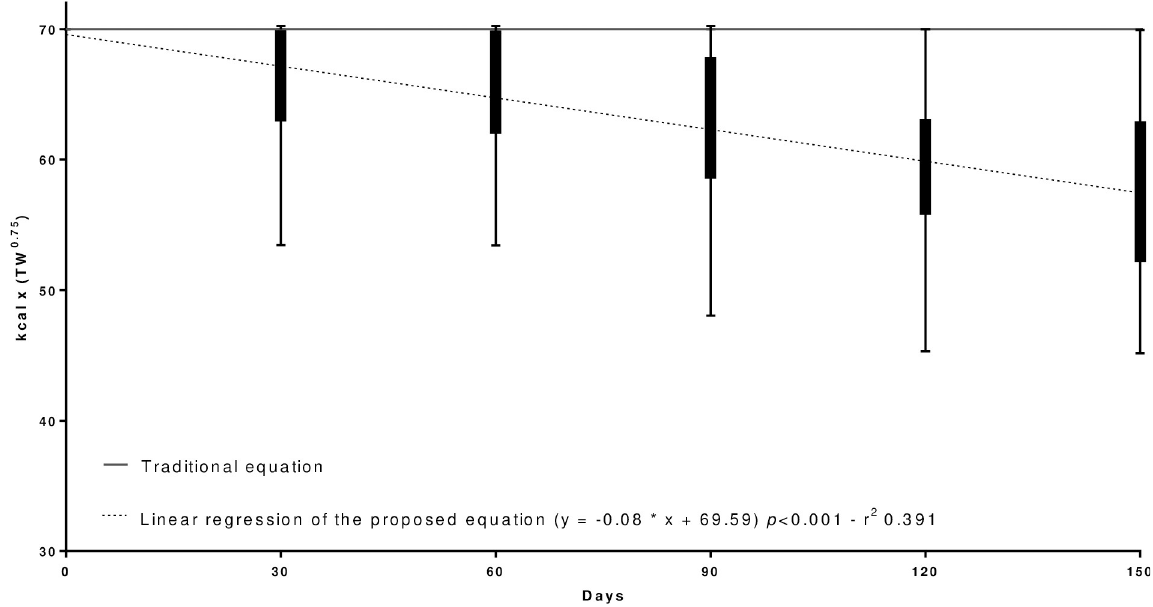
Fig 1. Regression analysis and complete distribution of the general weight loss equation [kcal x (TW 0.75 )] adjusted during the weight loss